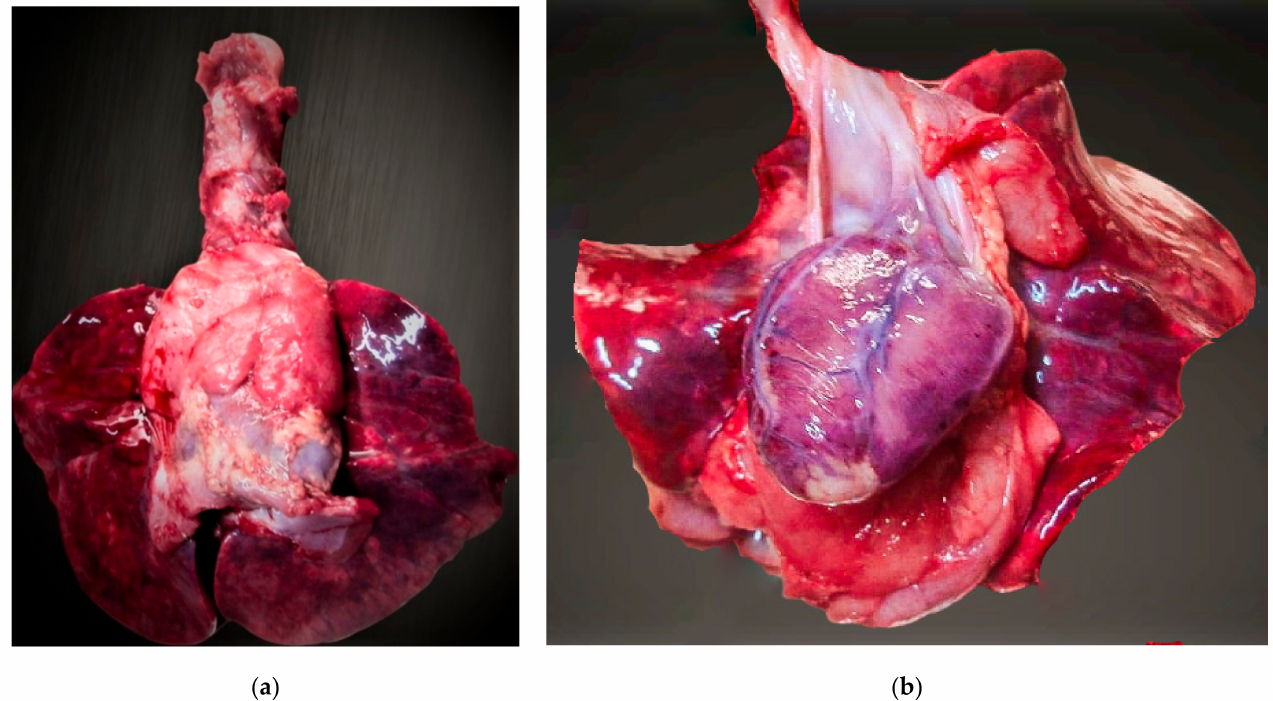
Figure 6. Infant cardiopulmonary system: ( a ) Overview: purple–brownish lungs, with multiple subpleural petechiae and increased consistency. ( b ) Close-up: opened pericardium, multiple macroscopically visible areas of thrombosis in the